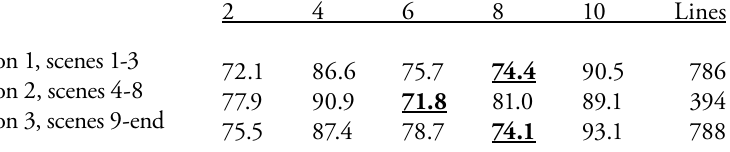
Table 1 – Arden of Faversham : Per cent of Stresses on Strong Syllabic Positions